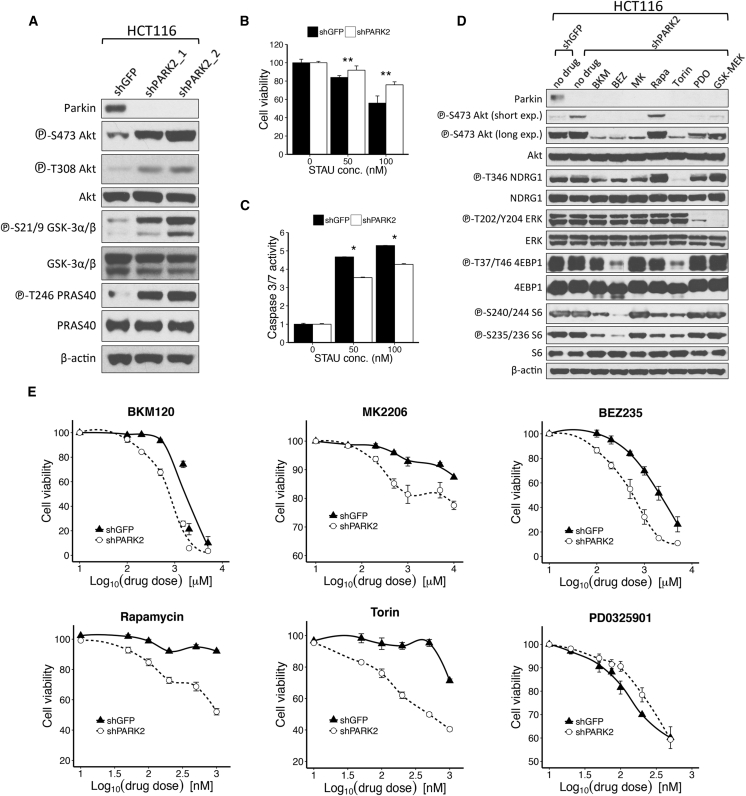
PARK2 Depletion Contributes to the Activation of the PI3K/Akt Pathway(A) Immunoblotting analysis of HCT116 cells stably transfected with control GFP (shGFP) or PARK2 (shPARK2_1 and shPARK2_2) lentiviral hairpins.(B and C) Shown is the (B) CellTiter 96 AQueous Non-Radioactive Cell Proliferation (MTS) assay and (C) caspase-3/7 activity assay of shGFP or shPARK2 HCT116 cells, following treatment with increasing concentrations of staurosporine (50 and 100 nM) for 1 hr (MTS assay, p = 0.001 for 50-nM and p = 0.0008 for 100-nM treatment; caspase-3/7 assay, p = 0.043 for 50-nM and p = 0.036 for 100-nM treatment).(D) Immunoblotting analysis of shGFP and shPARK2 HCT116 cells following treatment with the indicated compounds: 1 μM BKM (NVP-BKM120) or 500 nM BEZ (NVP-BEZ235) for 24 hr, 500 nM MK (MK 2206) for 4 hr, 100 nM Rapa (Rapamycin) or Torin for 2 hr, 100 nM PD0 (PD0325901) for 1 hr, or 10 nM GSK (GSK1120212) for 6 hr.(E) Drug dose-response curves of shGFP and shPARK2 HCT116 cells treated with the indicated compounds for 24 hr (NVP-BKM120, p = 0.014; NVP-BEZ235, p = 9.28 × 10−5; MK 2206, p = 1 × 10−4; Rapamycin, p = 1.45 × 10−11; Torin, p = 6.73 × 10−10; PD0325901, p = 0.02; and GSK1120212, p = 0.03, two-way ANOVA). Data are represented as mean ± SEM (∗p < 0.05 and ∗∗p < 0.01, two-tailed t test).See also Figure S2.